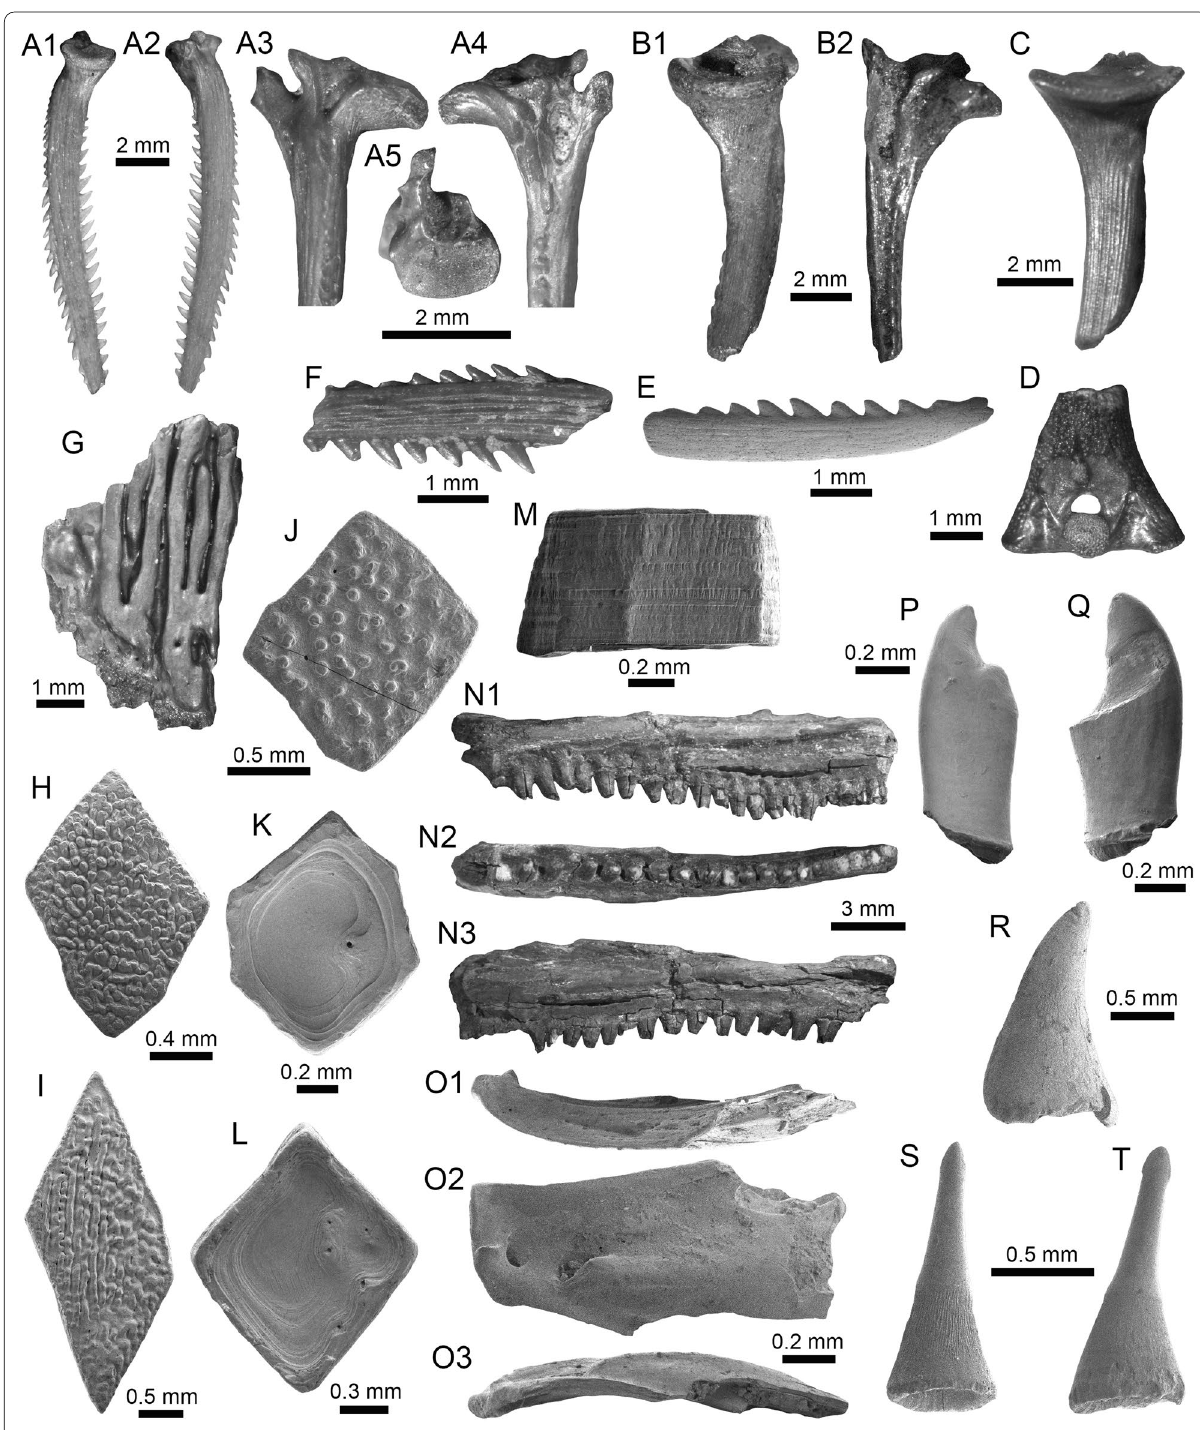
Fig. 6 Siluriformes, Osteoglossiformes and other bony fishes from the Iquitos assemblage. A1 – A5 Left pectoral fin‑spine of Pimelodidae indet. (PIMUZ A/I 4974). B1 – F Dorsal ( D : PIMUZ A/I 4971; E : PIMUZ A/I 4983) and pectoral fin‑spines ( B1 – B2 : PIMUZ A/I 4986; C, F : PIMUZ A/I 4971) of Siluriformes indet. G Fragment of a posterior field scale assigned to ?† Acregoliath sp. (PIMUZ A/I 5047). H – M . Squamules of ?Osteoglossoidei (PIMUZ A/I 5054). N1 – T Maxilla ( N1 – N3 : PIMUZ A/I 4599), dentary ( O1 – O2 : PIMUZ A/I 4980), pharyngeal and other teeth ( P – T : PIMUZ A/I 4964) of indet. actinopterygians. Views: anterior ( A3 , D ), dorsal ( A1 , B1 , C , O1 ), external surface ( G – J ), internal surface ( K – L ), lateral ( M ), left lateral ( N1 , O2 ), right lateral ( N3 ), posterior ( A4 , B2 ), proximal ( A5 ), ventral ( A2 , N2 , O3 ), and indet. ( E , F , P – T